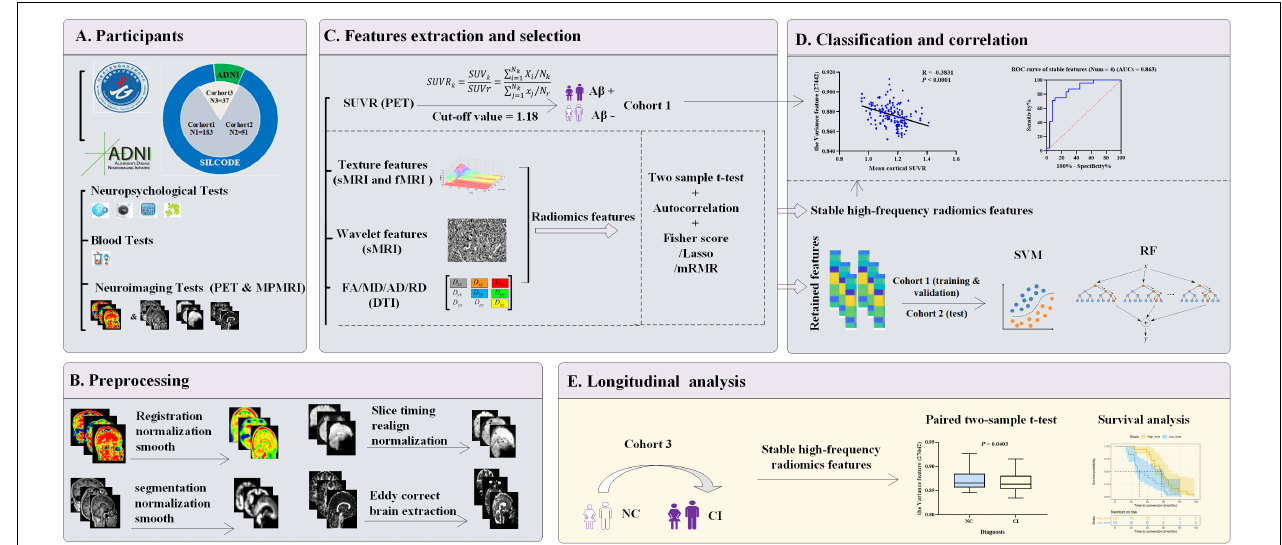
FIGURE 1 | Workflow diagram. (A) Three cohorts were enrolled. Cohort 1 ( n = 183) and cohort 2 ( n = 51) were both from the SILCODE project and divided qualitatively by A β status or future cognitive outcomes, respectively. Cohort 3 ( n = 37) included 24 “converters” from SILCODE and 13 from the ADNI. All participants were cognitively healthy at baseline and were evaluated in a standardized protocol. (B) Preprocessing of amyloid PET and MPMRI was performed for each modality. (C) Radiomics features were extracted from each modality, and a novel method characterized by the combination of function perturbations ( t -test, autocorrelation test, and three independent algorithms) and sample perturbations (five-fold cross-validation and 100 repetitions) was performed to select features from the training dataset (80% of cohort 1). (D) Retained features were incorporated into classification models and verified in the validation (the remaining 20% of cohort 1) and test dataset (cohort 2), respectively. Furthermore, during the process of selection, stable high-frequency features were identified that were undisturbed by perturbations and correlated with the SUVR values, which played a good role in predicting prospective cognitive decline (cohort 2). (E) Levels of stable high-frequency features were tested to determine whether they change with cognitive decline or impact the conversion time. ADNI, Alzheimer’s Disease Neuroimaging Initiative; MRI, magnetic resonance imaging; sMRI, structural MRI; fMRI, functional MRI; DTI, diffusion tensor imaging; MPMRI, multiparameter MRI; PET, positron emission tomography; FA, fractional anisotropy; MD, mean diffusivity; AD, axial diffusivity; RD, radial diffusivity; SUVR, standard uptake value ratio; A β , amyloid β ; Lasso, least absolute shrinkage and selection operator; mRMR, max-relevance and min-redundancy; SVM, support vector machine; RF, random forest; ROC, receiver operating characteristic; AUCs, areas under curve; NC, normal control; CI, cognitive